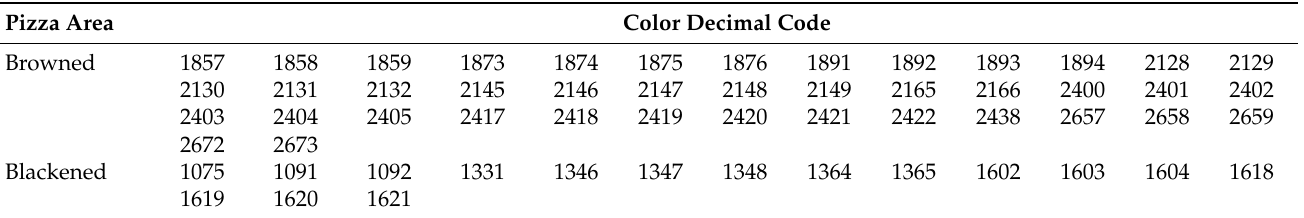
Table 3. Decimal color codes associated with the browned and blackened areas of a pizza undergoing baking in a wood-fired